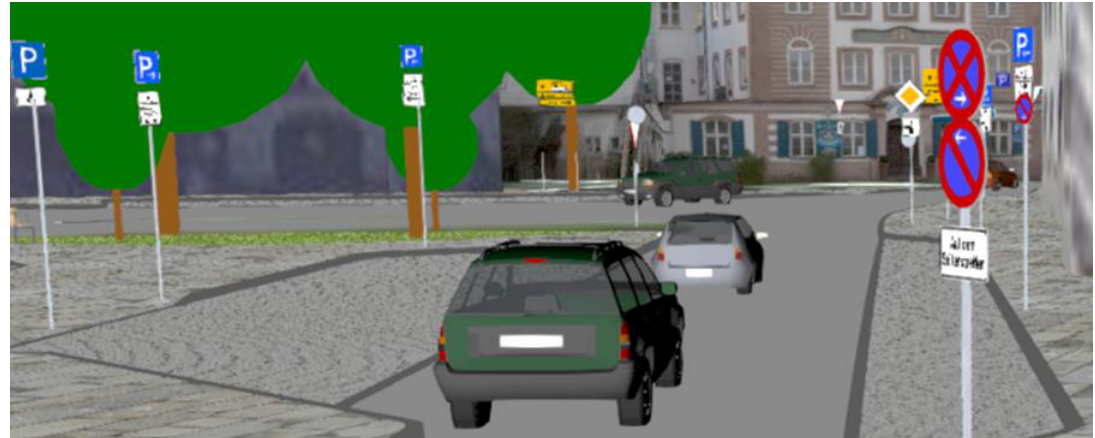
Figure 13. Streetspace model including city furniture objects generated from mobile mapping data and traffic simulation.